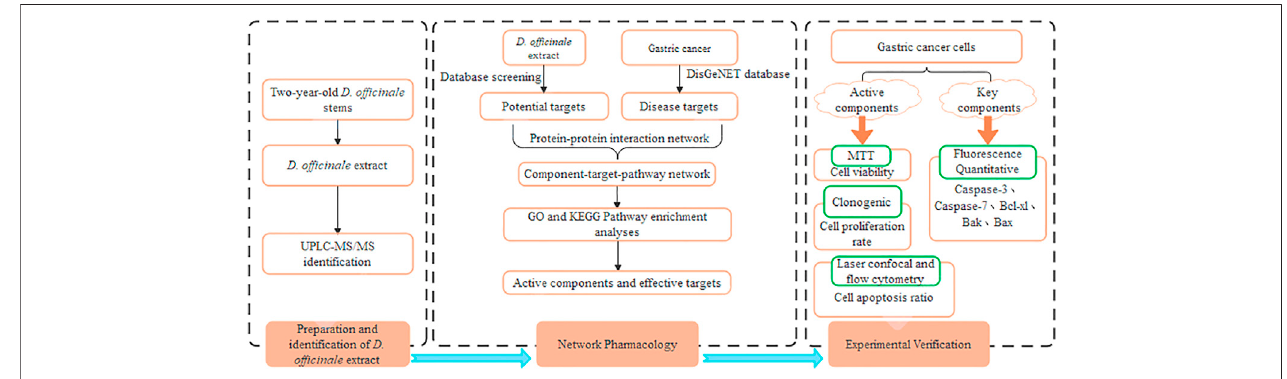
FIGURE 1 | Flowchart of the network pharmacological and experimental studies of the D. of fi cinale extract in human gastric cancer cells.